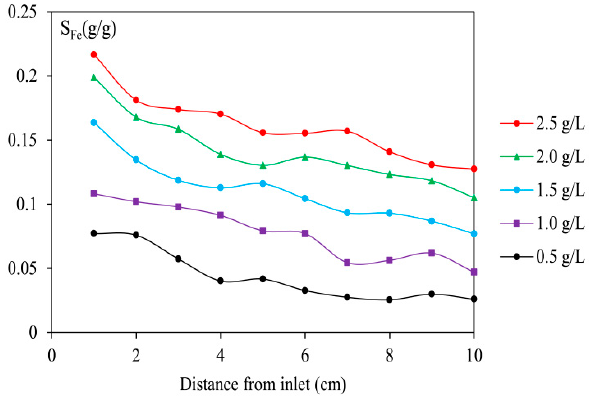
Figure 5. Iron concentration profiles along the column. S Fe represents iron content per unit solid matrix, namely the mass of iron to the mass of glass beads.